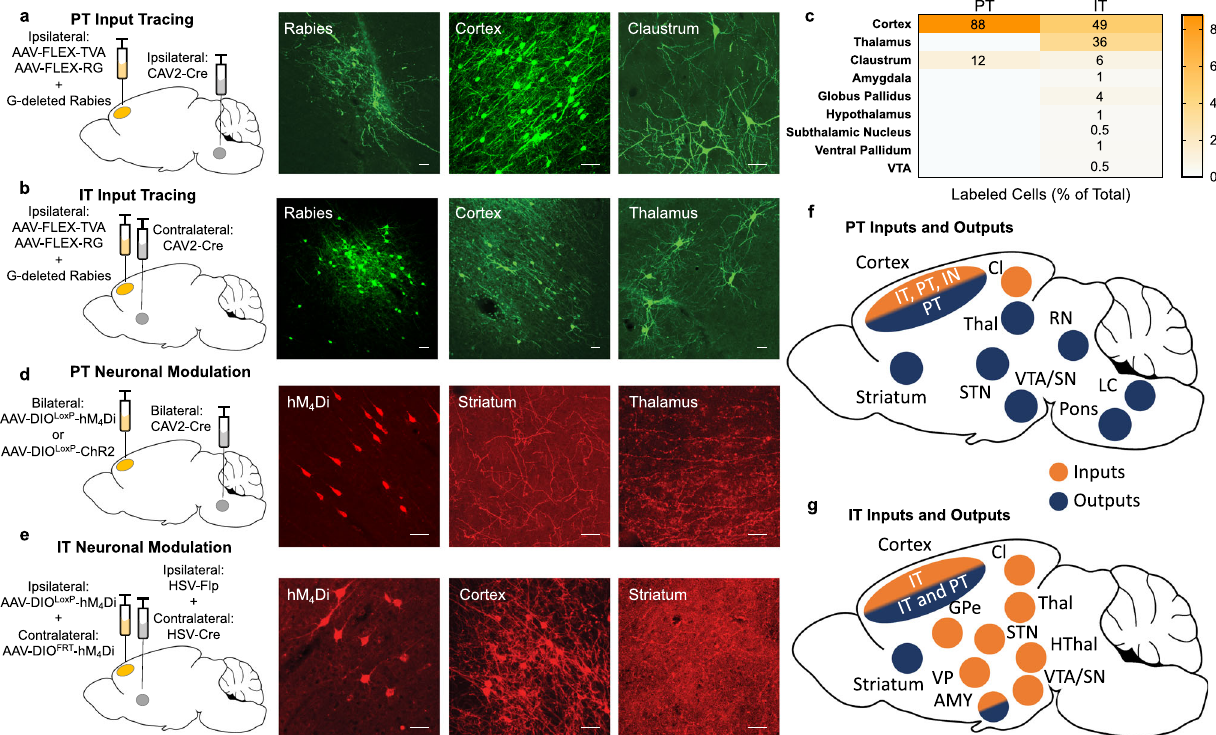
Fig. 1 PT and IT neurons in ACC have distinct inputs and outputs. a , b Viral strategy using a modi fi ed rabies system for monosynaptic retrograde tracing in PT ( a ) or IT ( b ) neurons. Retrograde CAV2-Cre virus was injected unilaterally into the pyramidal tract ( a ) or the dorsomedial striatum (IT) and Cre- dependent TVA and RG vectors were infused into the ipsilateral ACC along with a modi fi ed EnvA G-deleted rabies-eGFP. Representative images of GFP- tagged rabies immuno fl uorescence in PT ( a , left panel) and IT ( b , left panel) neurons at the site of infection in the cortex, PT inputs from cortex and claustrum ( a , middle and right panels), and IT inputs from cortex and thalamus ( b , middle and right panels). These regions represent the two strongest inputs into PT ( a ) and IT ( b ) cells. Scale bars, 50 µ m. c Summary of the relative input strength (by %) to PT and IT neurons in the ACC. Data from 25 PT cells and 315 IT cells. d , e Viral strategy for targeting transgenes bilaterally to PT ( d ) or IT ( e ) neurons. For PT neurons ( d ), CAV2-Cre was injected bilaterally into the pyramidal tract and a Cre-dependent hM 4 D i or ChR2 virus was injected bilaterally into the ACC. For IT neurons ( e ), retrograde HSV-Cre and HSV-Flp viruses were injected unilaterally into opposite hemispheres of dorsomedial striatum and the complementary Cre-dependent or Flp- dependent hM 4 D i virus was infused unilaterally into the contralateral ACC. Representative images of mCherry-tagged hM 4 D i immuno fl uorescence in PT ( d , left panel) or IT ( e , left panel) neurons in cortex, PT terminals in striatum and thalamus ( d , middle and right panels), and IT terminals in cortex and striatum ( e , middle and left panels). The cortex image in e (middle panel) also shows hM 4 D i -labeled IT cell bodies because of contralateral IT projections. Scale bars, 50 µ m. f , g Summary of the known PT ( f ) and IT ( g ) inputs and outputs. PT neurons have diverse outputs, but a restricted source of inputs originating in cortex and claustrum whereas IT neurons have a restricted set of outputs to contralateral cortex, striatum, and amygdala, but a diverse set of